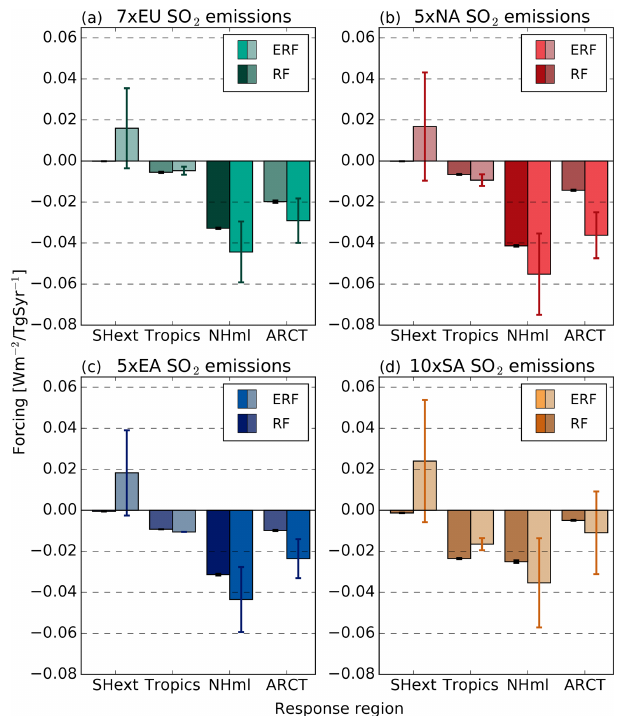
Figure 6. Latitudinal RF and ERF for SO 2 emission (Wm − 2 (TgSyr − 1 ) − 1 ) for (a) EU emissions, (b) NA emis- sions, (c) EA emissions and (d) SA emissions. In each pair of bars the left bar indicates RF and the right bar indicates ERF. Grey shading indicates that the forcing response is not statistically significant ( p > 0 . 05) compared to the control simulation. The error bars show the standard